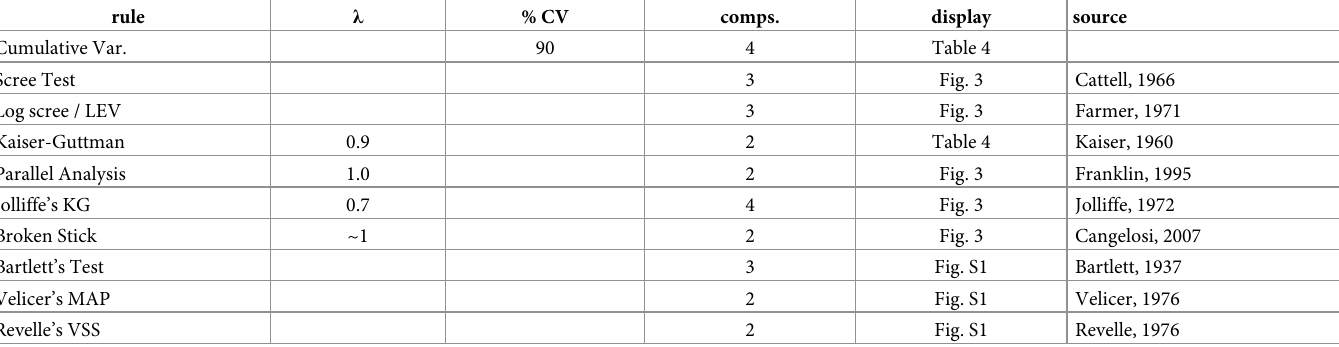
Table 2. Retained PCA components and stopping rules. All rules suggest retaining at least the first two and perhaps as many as four components. The last two compo- nents (that distinguish tone/interval and rhythm/repetition) were discarded based on λ < 0.71. PC2, the most reliably informative component, spreads the six variables into three distinct clusters (Fig 3) and is retained under all stopping